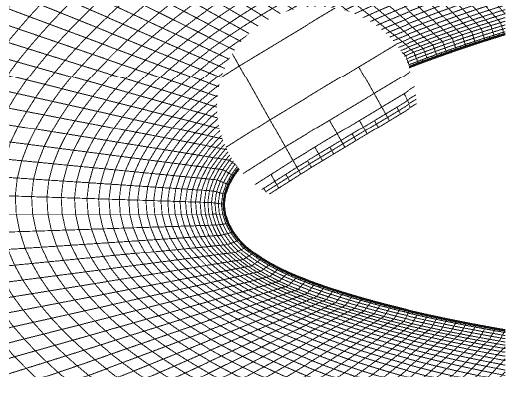
Figure 2: Near-wall view of the